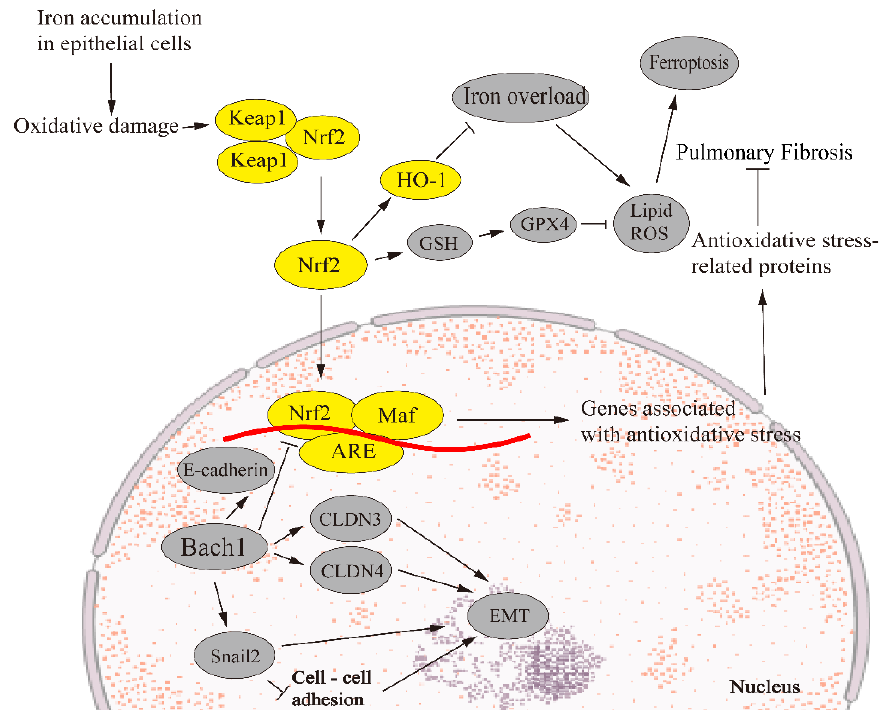
Figure 2. Ferroptosis regulates EMT in pulmonary fibrosis via the Nrf2 signaling pathway. Under normal conditions, Keap1 binds to Nrf2, which is degraded by ubiquitination. However, when iron accumulates in epithelial cells, the imbalance between oxidation and antioxidant reaction results in oxidative stress. Nrf2 dissociates from Keap1 during oxidative stress, and Nrf2 enters the nucleus to form heterodimerization with small Maf or Jun proteins. This dimer binds to ARE, transcriptionally activating its target genes and restoring cell homeostasis. Bach1 regulates EMT through CLDN3 and CLDN4, and Bach1 regulates FOXA1 and snail2, forming GRN to regulate EMT. Bach1 decreased the expression of the E-cadherin gene and promoted the occurrence of EMT. Meanwhile, Bach1 directly activates snail2, which promotes EMT by inhibiting cell–cell adhesion. Knockdown of Nrf2 significantly reduces heme oxygenase 1 (HO-1), promotes the accumulation of lipid peroxidation and causes ferroptosis.